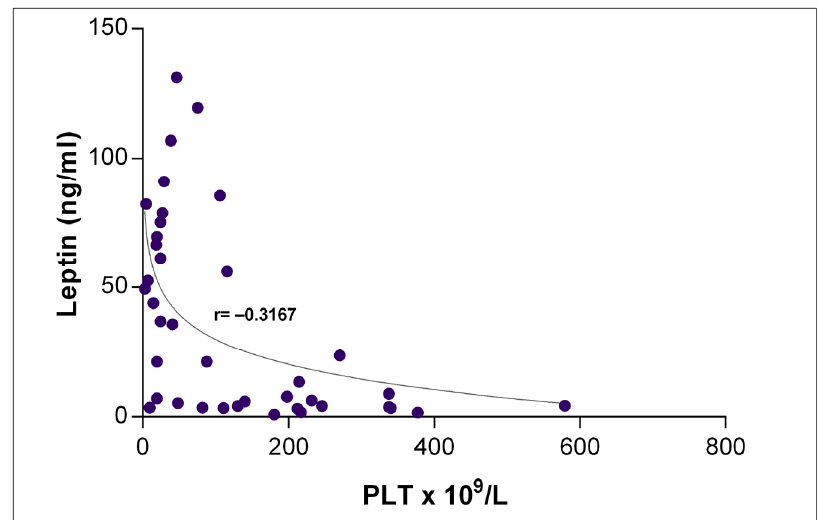
Figure 2. Correlation of plasma leptin levels and platelet (PLT) count. Measurement of plasma TGF- β 1 levels in patients and controls (Figure 3) revealed that TGF- β 1 levels were significantly lower in children with acute ITP compared with controls and remained significantly lower in patients on IVIg and/or steroid therapy or even when the disease went into remission.